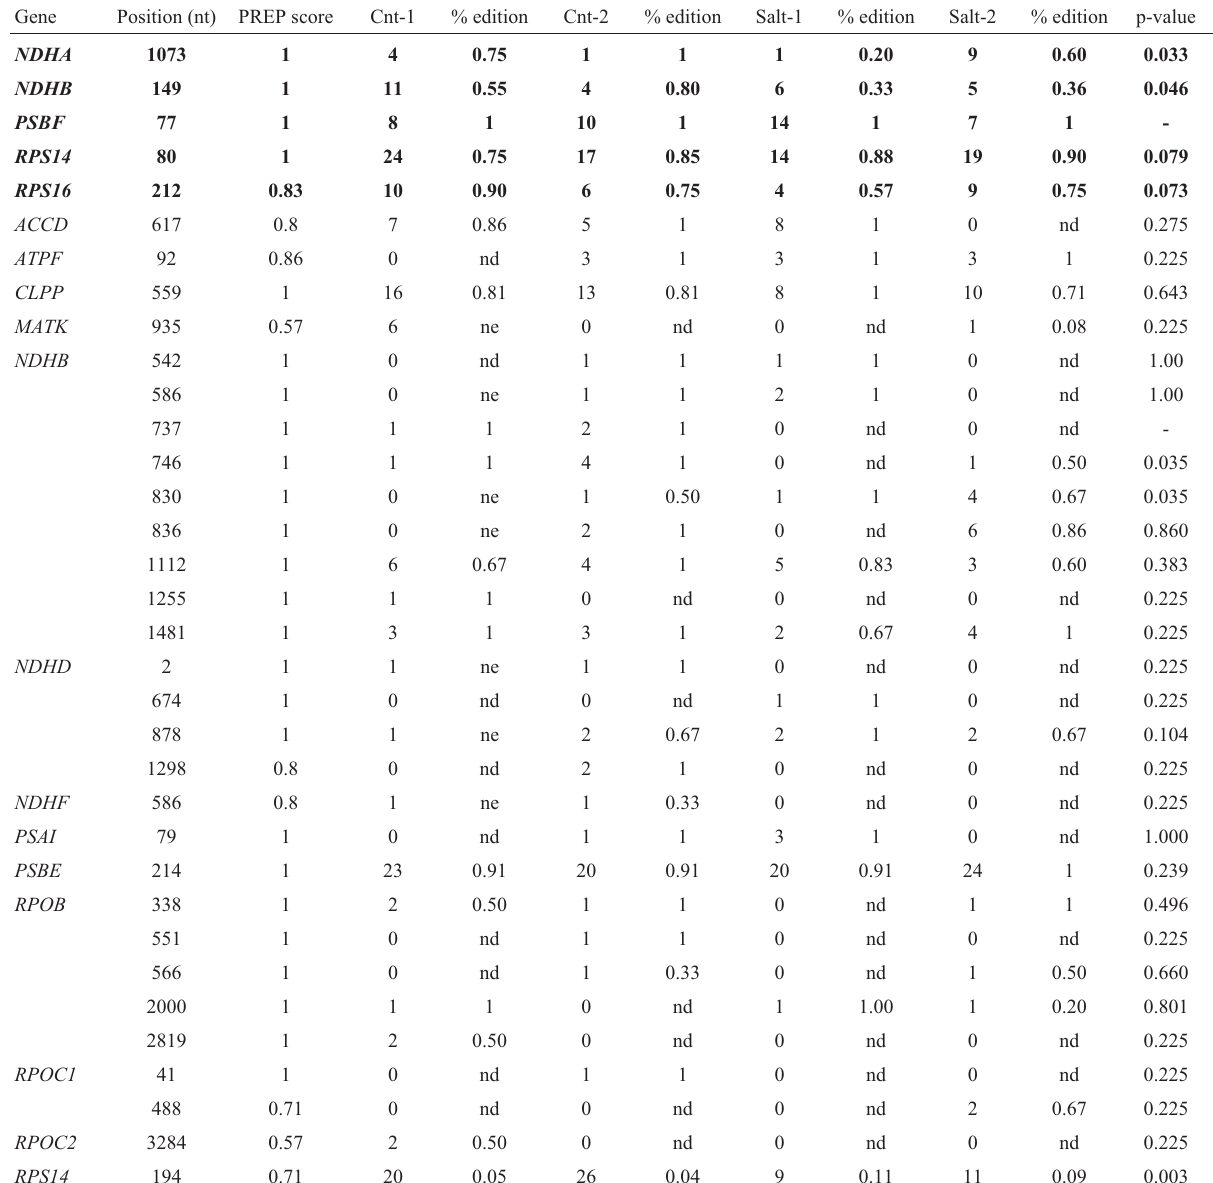
Table 1 - Quantitative distribution of sRNAs reads in plastid editing sites, editing percentages and p-values (t-test).